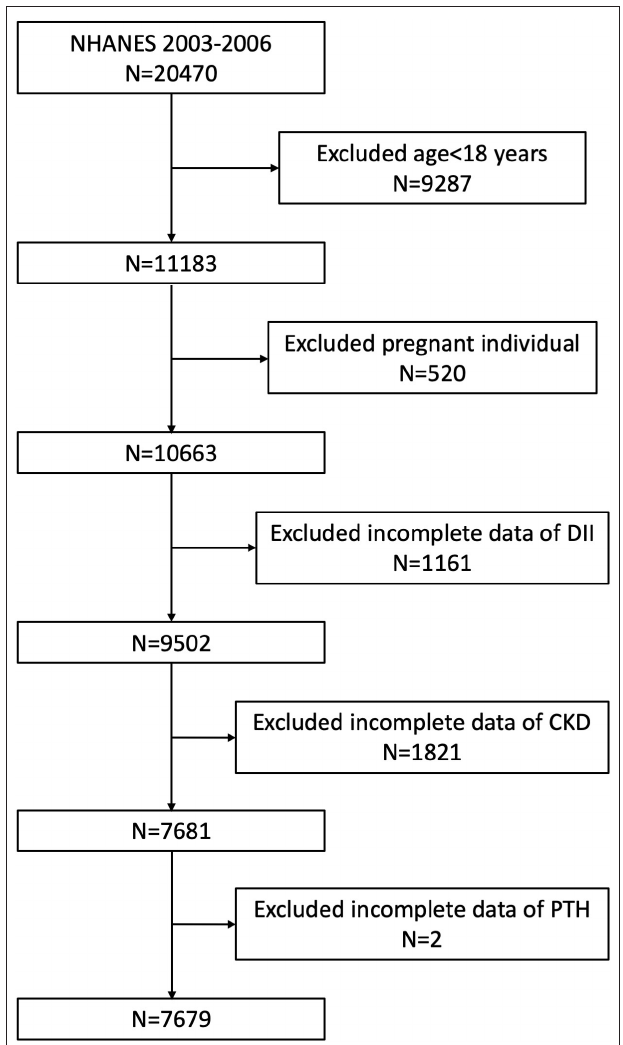
FIGURE 1 | A flowchart of the sample selection from NHANES